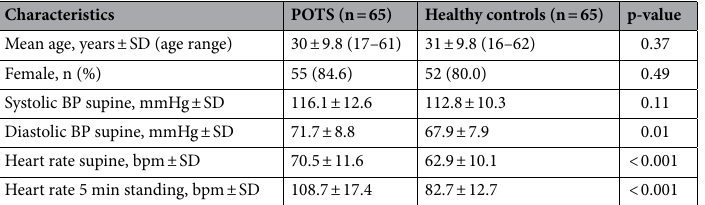
Table 1. Study characteristics of the population. BP blood pressure, bpm beats per minute, POTS postural orthostatic tachycardia syndrome, SD standard